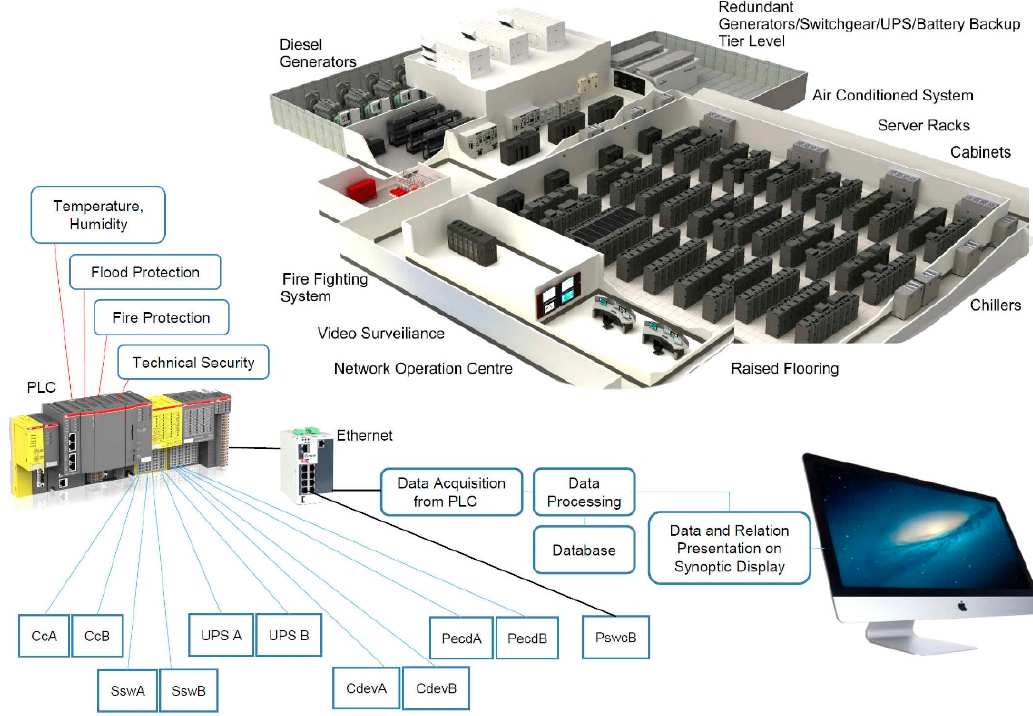
Figure 1. Data center technical infrastructure monitoring.